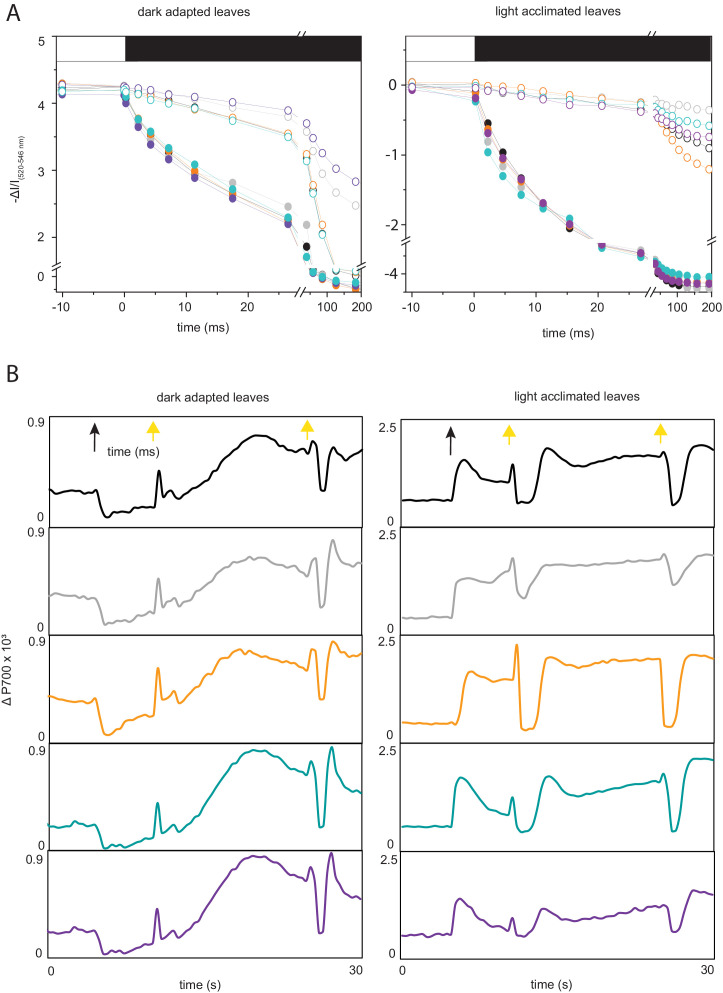
Raw data from ECS and PSI responses to high light treatment.(A) Representative normalised ECS traces following high light exposure to either red light (filled circles) or far red light (empty circles) after dark adaptation (left) and light acclimation at 150 µmol photons m−2 s−1 actinic light (right). Bars above graphs indicate the end of high light treatment and transition to dark relaxation. Typical traces from six to seven measurements on independent plants are shown. Genotypes from top to bottom: black, wt; grey, fnr1; orange, fnr1-ZmFNR1; cyan, fnr1-ZmFNR2; purple, fnr1-ZmFNR3. (B) P700 traces on high light exposure following dark adaptation (left) and light acclimation at 150 µmol photons m−2 s−1 actinic light (right). Black arrow indicates start of illumination at 1100 µmol photons m−2 s−1, and yellow arrows indicate application of saturating pulses. Data presented in Figure 5B is only calculated from pulses applied 20 s after the start of the high light treatment. Typical traces from 6 to 12 measurements on independent plants are shown. Genotypes coloured as for part (A). Values of Pm and their statistical analysis are provided in Supplementary file 2f.